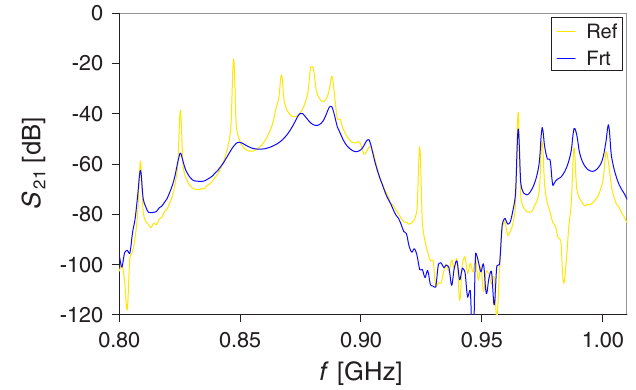
FIG. 8. (Color) HOM dipole modes in the five-cell Cu cavity without (Ref) and with (Frt) absorber.